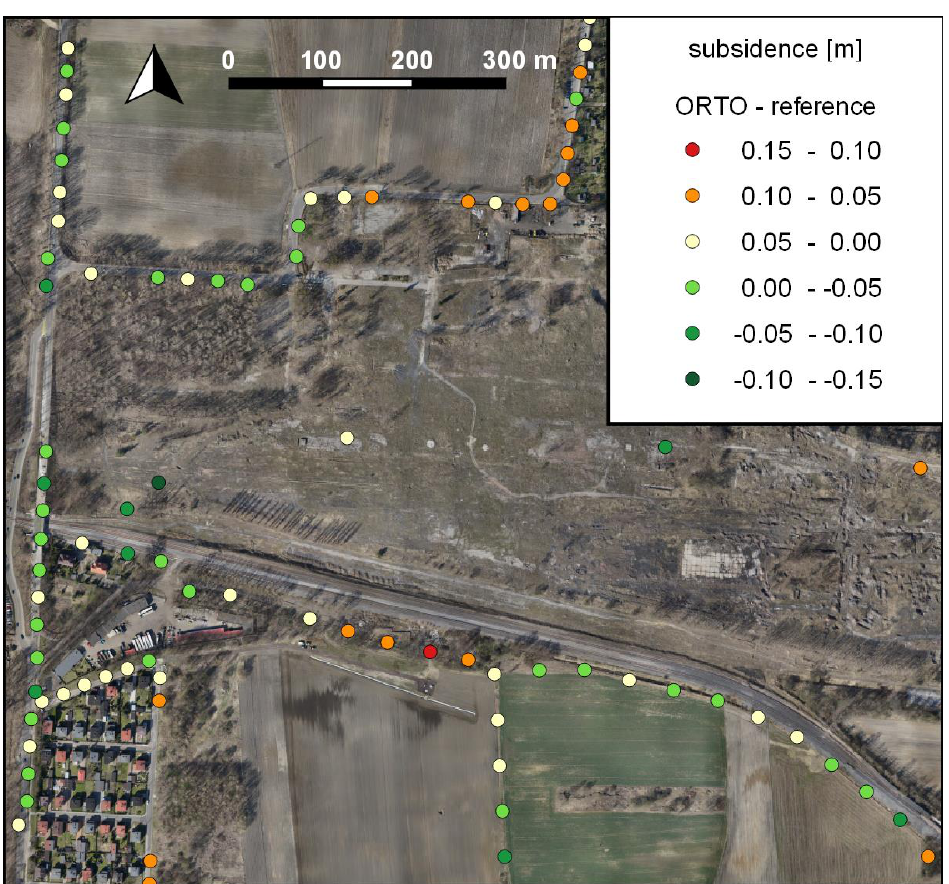
Figure A2. Discrepancies between vertical displacements determined via the UAV photogrammetric method (ORTO method) and reference measurements at the Piekary site.